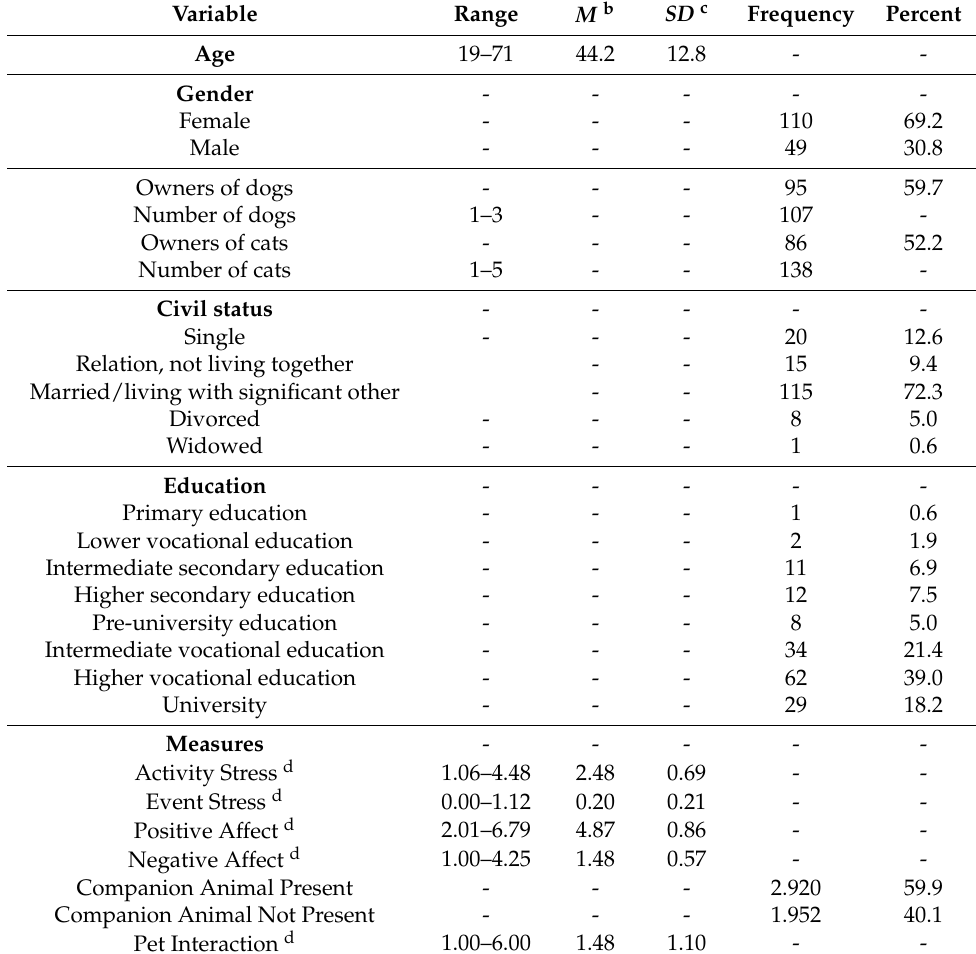
Table 1. Descriptive data of sample a